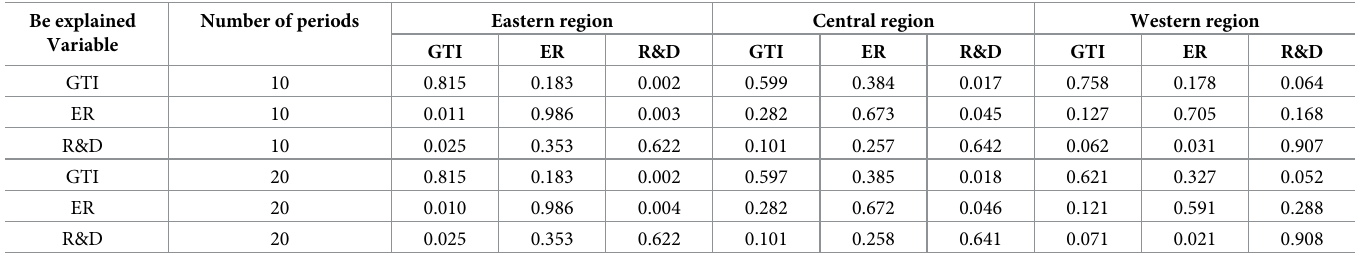
Table 6. Results of variance